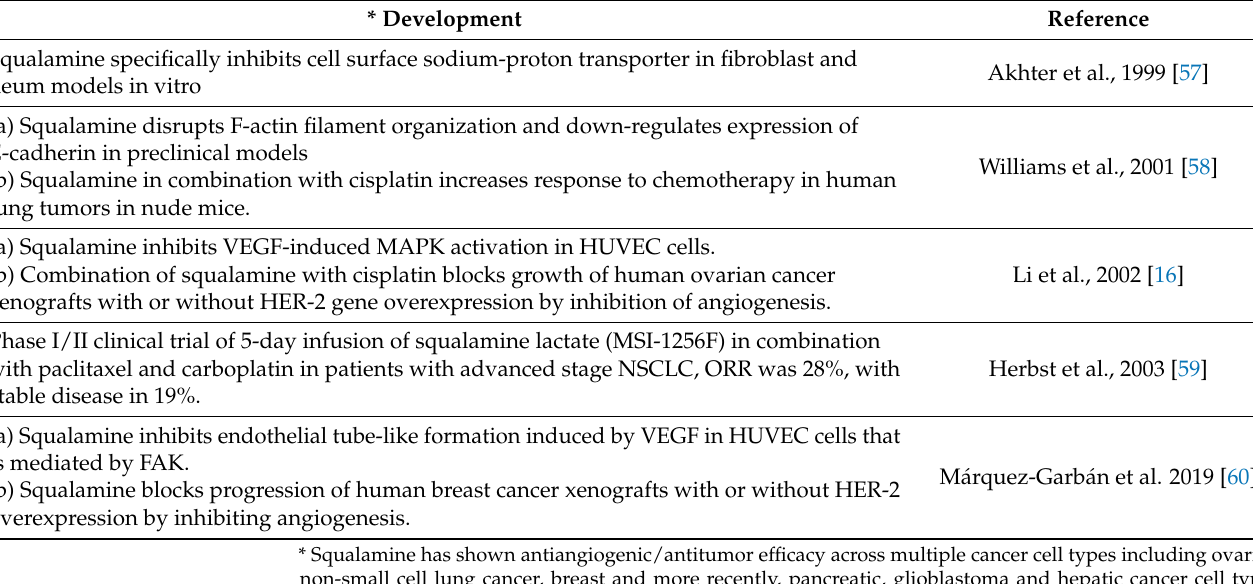
Table 1. Summary of Key Findings on Squalamine Actions in vitro and in vivo.